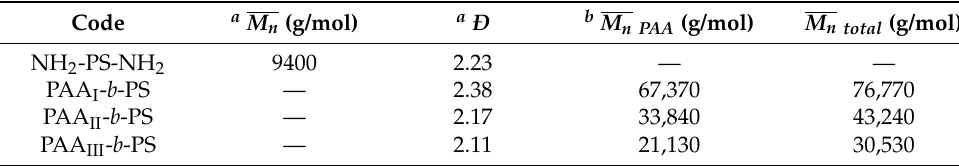
Table 1. Characterization of synthesized polymers.